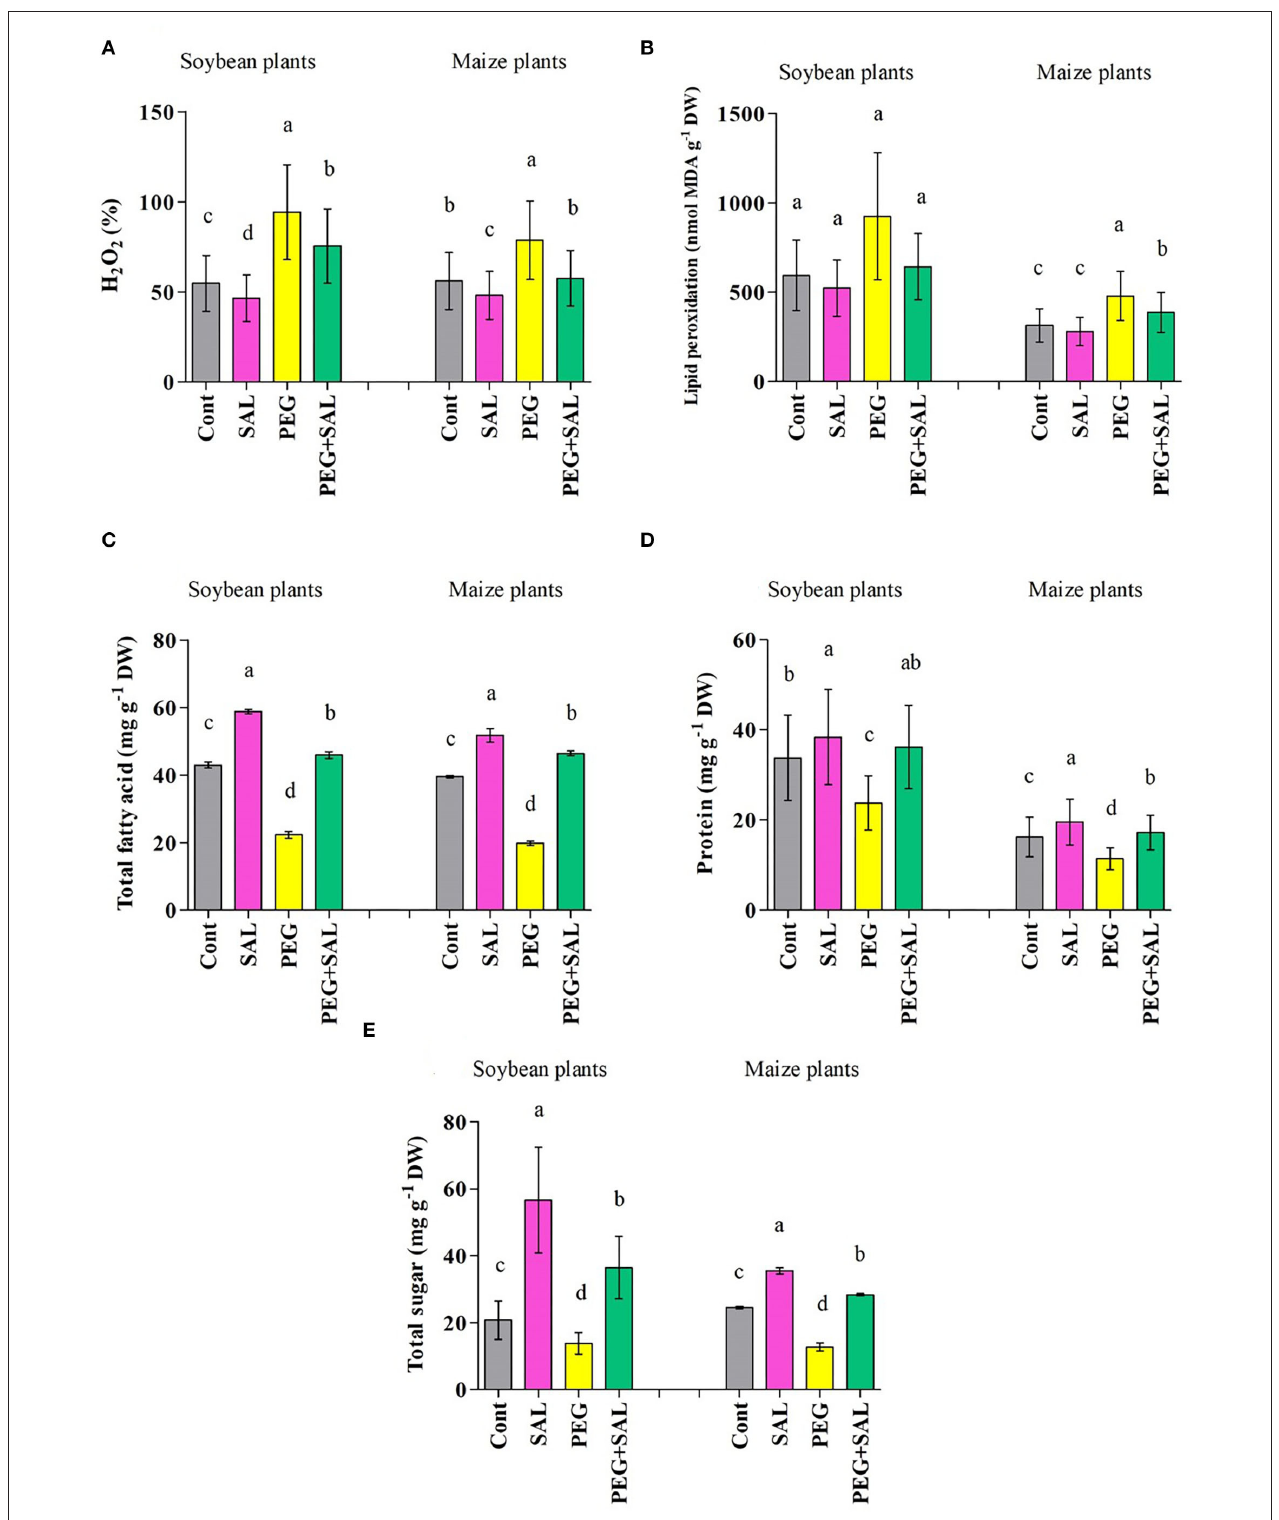
FIGURE 5 | (A) H 2 O 2 , (B) MDA, (C) total fatty acid, (D) protein, and (E) sugar content in leaves of soybean and maize grown under normal and stress conditions and treated with salvianolic acid for 8 days (8DAT). Treatments: Cont (control), SAL (0.1 µ M salvianolic acid), SAL (1 µ M salvianolic acid), PEG (25% polyethylene glycol), SAL (0.1 µ M salvianolic acid) + PEG (25% polyethylene glycol), and SAL (1 µ M salvianolic acid) + PEG (25% polyethylene glycol). Values show the mean ± SE ( n = 6) and significant differences at p < 0.05 (Tukey’s test). Bars with different lowercase letters are significantly different from each other.